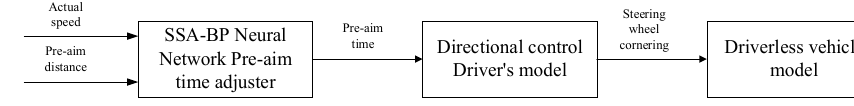
Figure 5. SSA ‐ BP neural network pre ‐ aim time adjuster workflow.